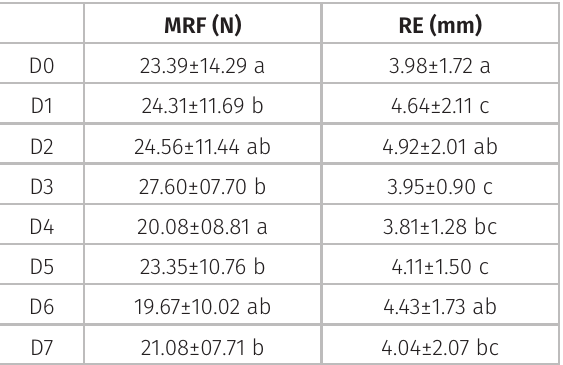
Table II. Mean and standard deviation of the maximum rupture force (MRF) and rupture elongation (RE) of the jejunum samples from cat cadavers chemically